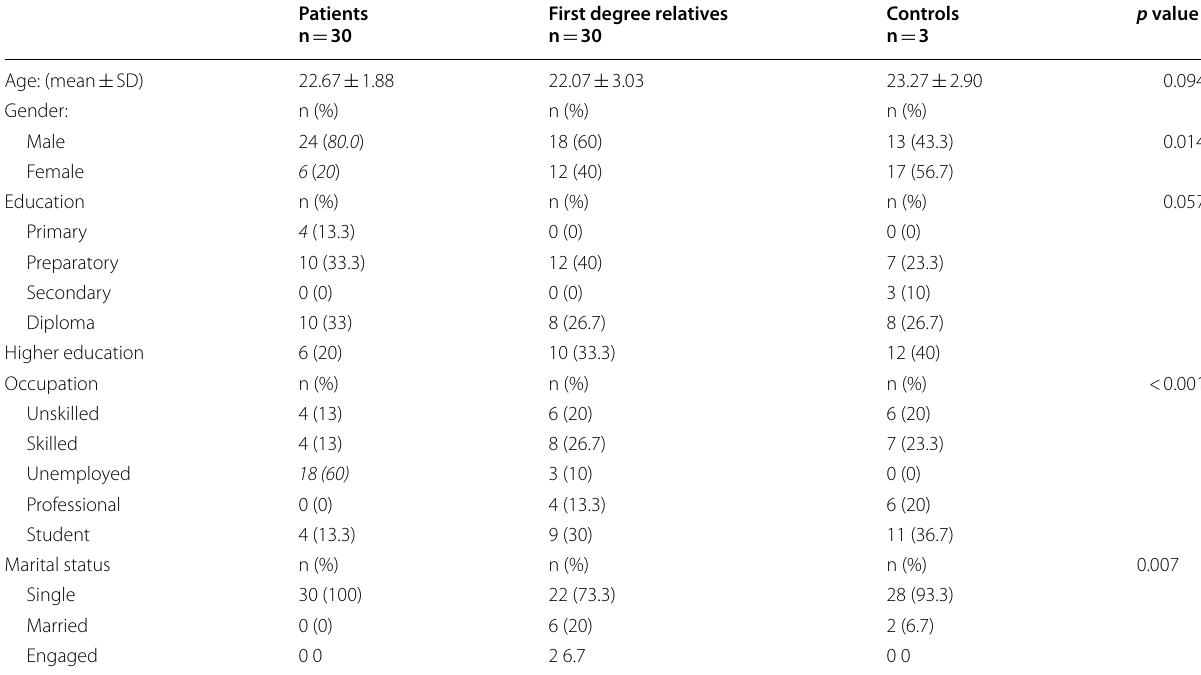
Table 1 Demographic characteristics of the participants of the three groups (patients with schizophrenia, first-degree relatives and healthy controls)